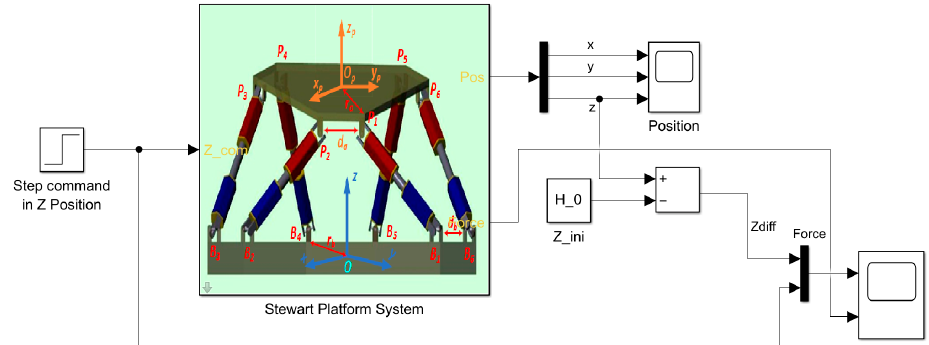
Figure 6. Simulink model of the controller and the applied step input for Z axis.